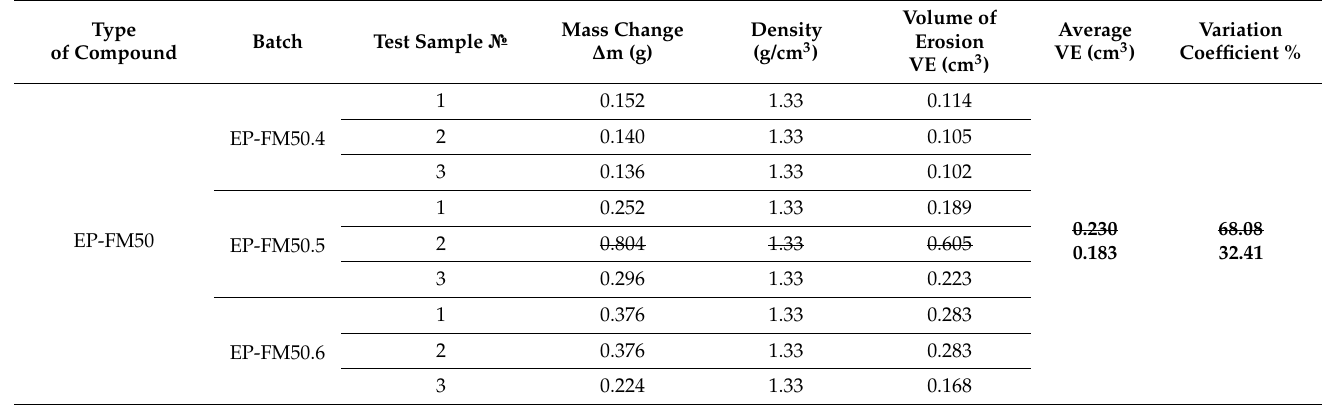
Table A24. Wear of filled epoxy binder (EP-FM50) at 180 ◦ C at an impingement angle of 45 ◦